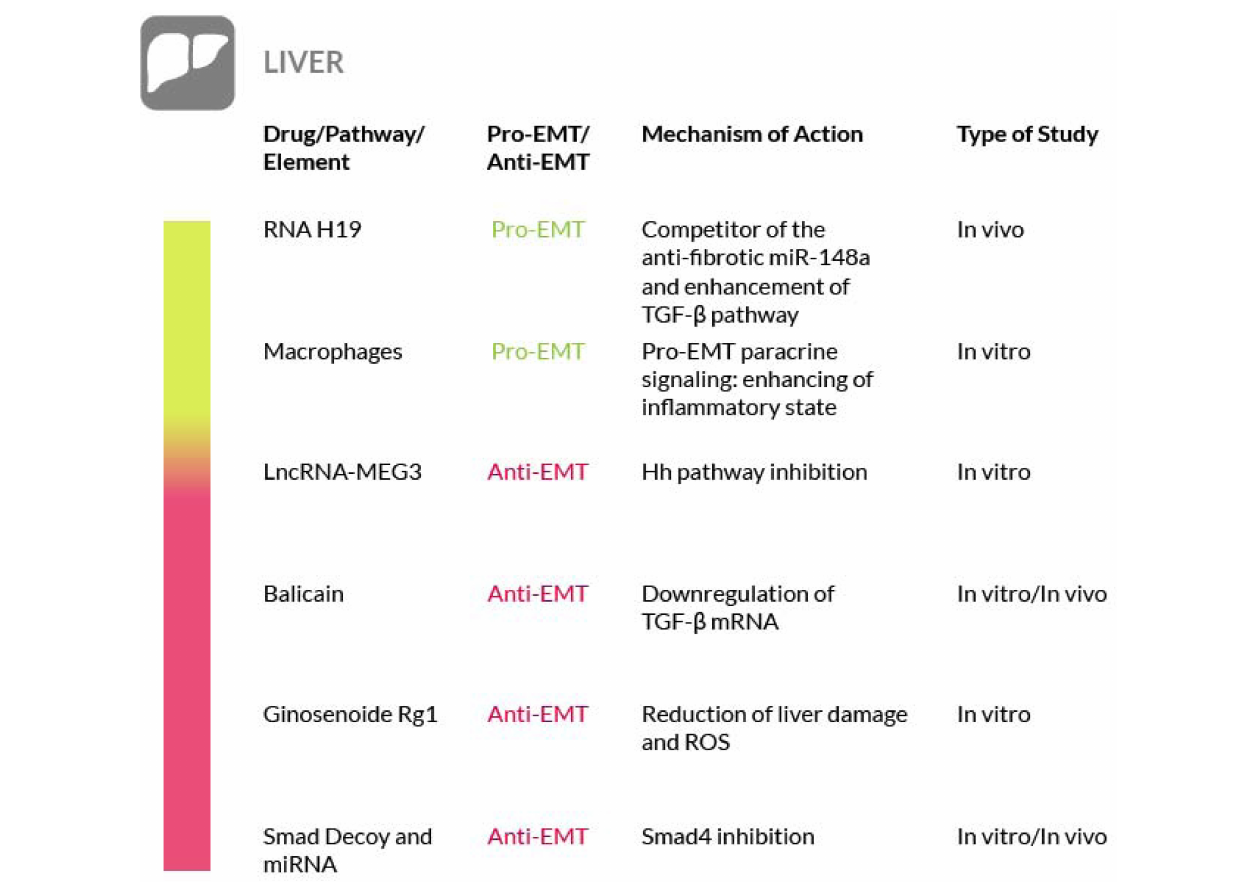
FIGURE 4 | Most relevant molecular mechanisms and possible drugs for the treatment of EMT in liver